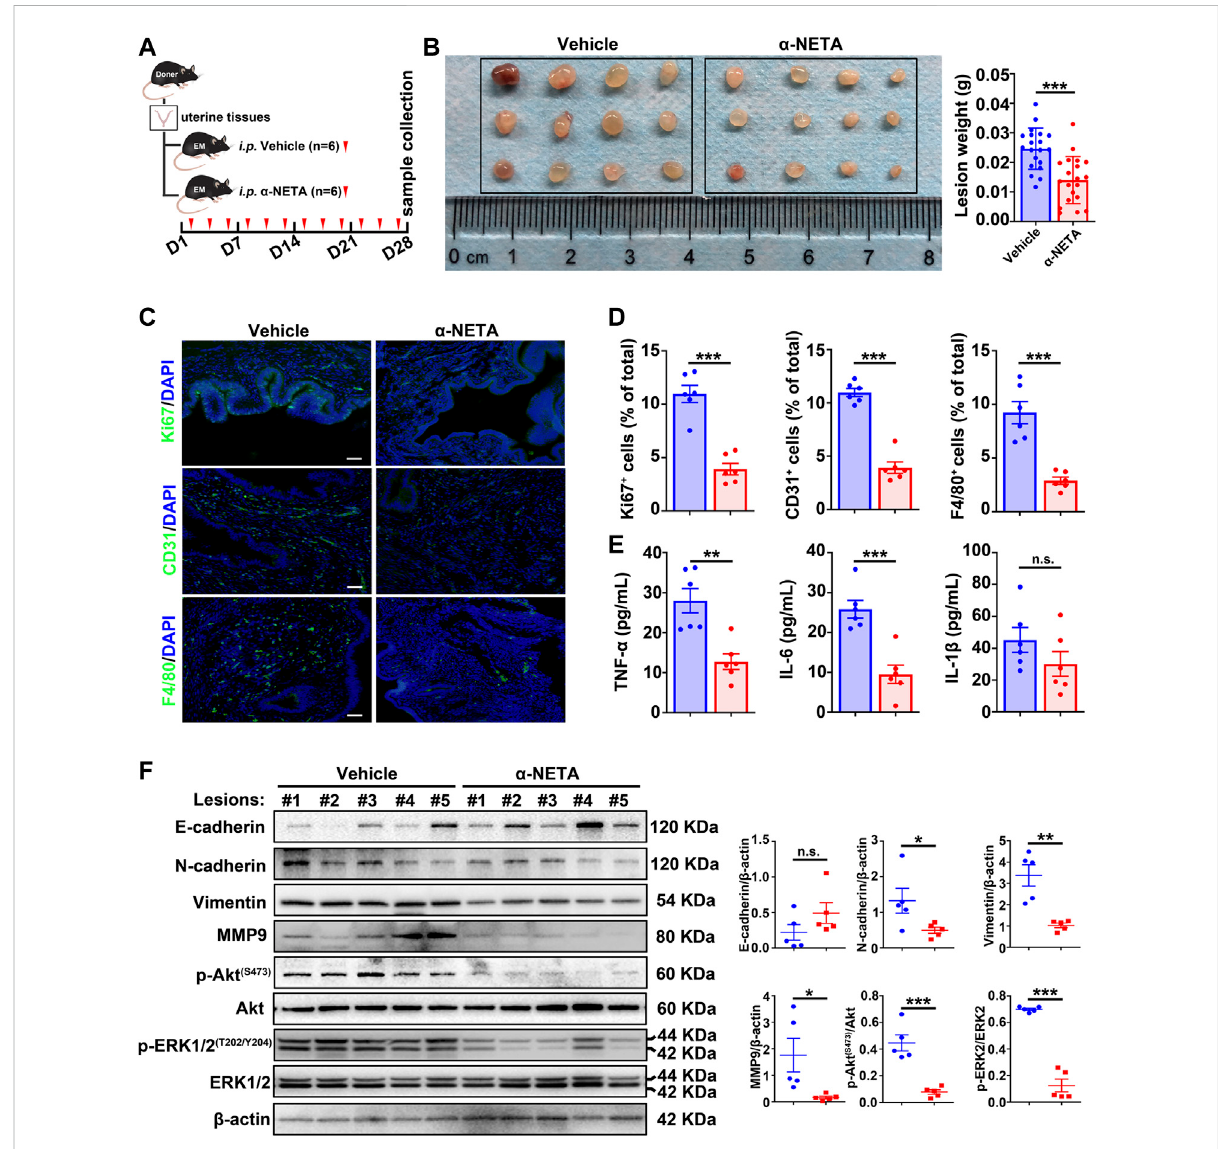
FIGURE 6 α -NETA alleviates endometriosis progression in vivo . (A) Schematic of animal experimental-2 to evaluate the effects of α -NETA on endometriosis in vivo . (B) After surgeries for 1-month, peritoneal lesions were excised, and the weight of lesions was measured. (C) Representative immuno fl uorescent images of Ki67, CD31, and F4/80 in lesions from the vehicle and α -NETA groups. Scale bars, 50 μ m. Nuclei were stained with DAPI. (D) The quantitative data of C was shown. (E) TNF- α , IL-6, and IL-1 β levels in peritoneal lavage fl uids from vehicle ( n = 6) and α -NETA administratedmice ( n =6)weredetected byELISA. (F) Immunoblots ofE-cadherin,N-cadherin,vimentin,MMP-9,p-Akt (S473) ,Akt,p-ERK1/2 (T202/Y204) , ERK1/2 in lesions from vehicle ( n = 5) and α -NETA ( n = 5). The densitometry of blots was shown. β -Actin served as a loading control. Data are shown as mean ± SD. ns. not signi fi cant; * p < 0.05; ** p < 0.01; *** p <